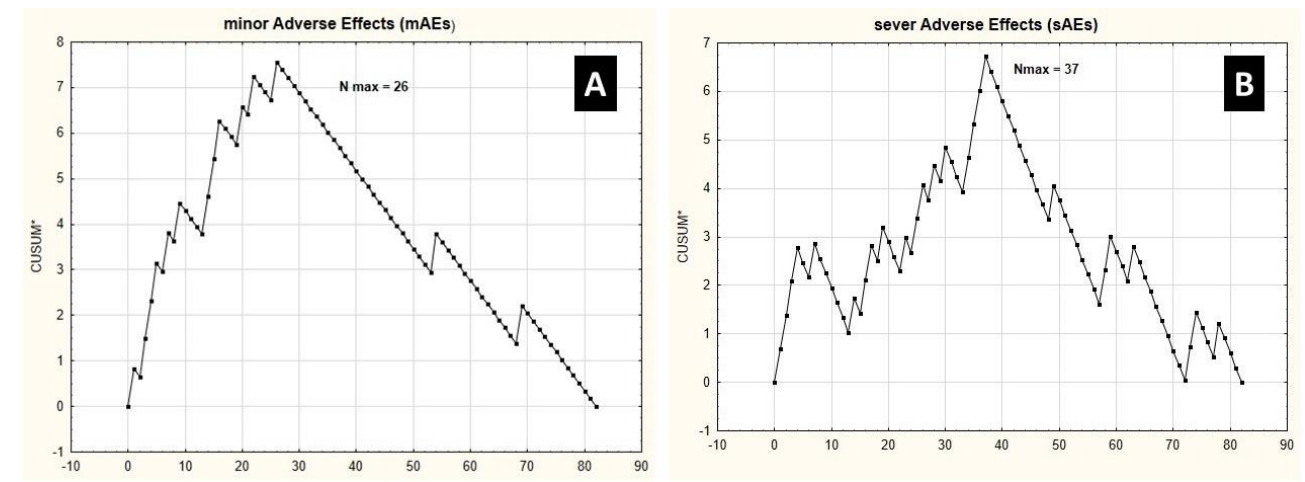
Figure 2. Cumulative sum control chart of operative (CUSUM *) minor adverse effects (mAEs) corresponding with grade I-IIIa complications according to the Clavien – Dindo classification ( A ) and severe adverse effects (mAEs) ( B ) matched with grade IIIb-V complications according to the Clavien – Dindo classification against the number of patients.